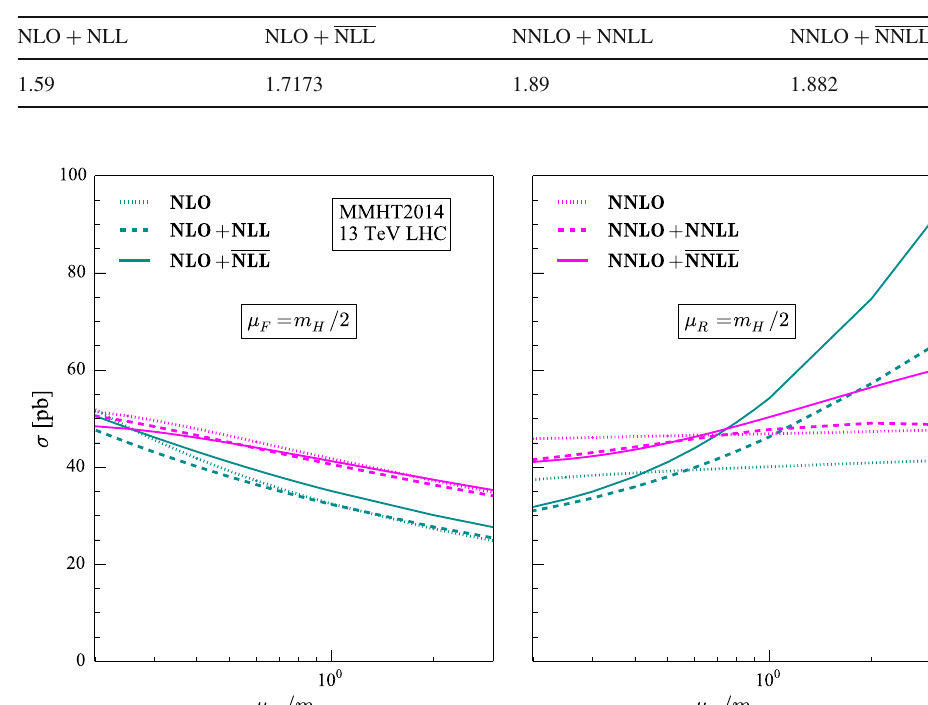
Table 10 Values of resummed SV + NSV cross section (in pb) at various orders in comparison to the fixed order results and resummed SV predictions at central scale value μ R = μ F = m H 2 NLO